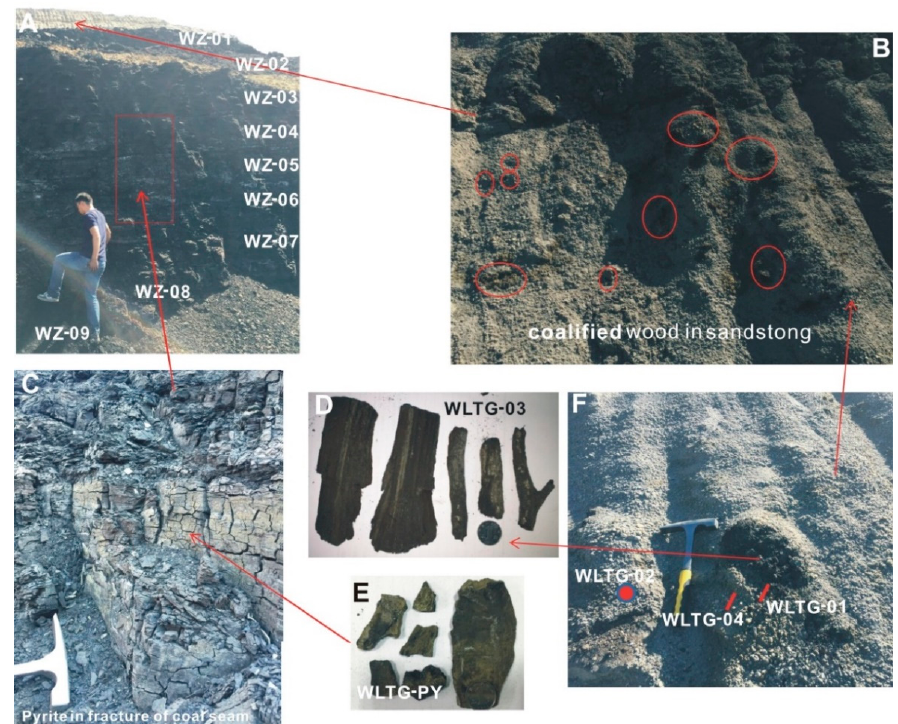
Figure 4. Samples collected from the Wulantuga open-pit mine. ( A ) The sampling location across the profile; ( B ) coalified woods in roof; ( C ) pyrite in fracture of coal seam; ( D ) coalified wood samples; ( E ) pyrite veins; ( F ) sampling location of coalified wood and roof glutenite